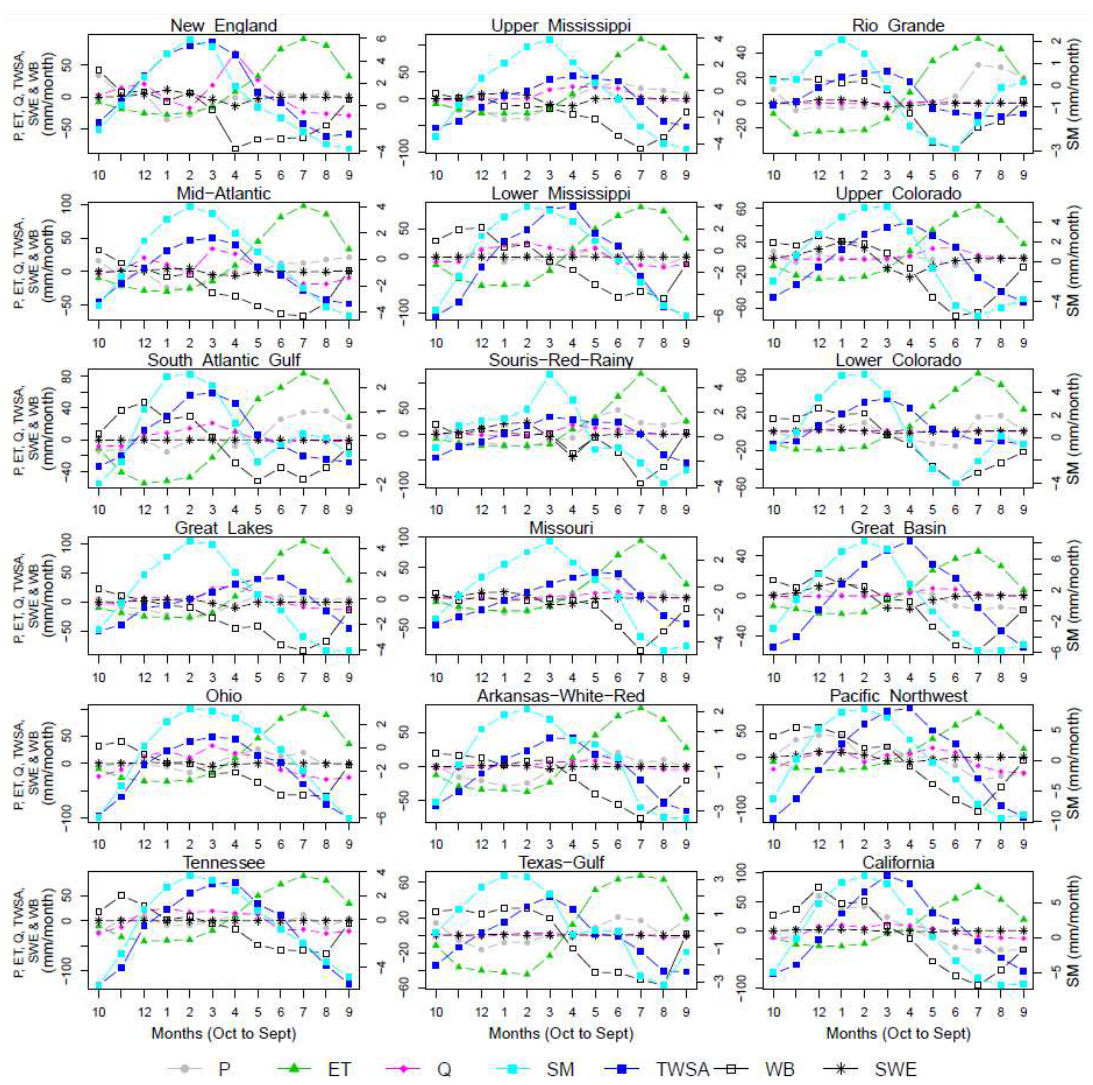
Figure 6. Comparison of hydrologic basin GRACE TWSA against other important hydrologic fluxes and parameters: (precipitation (P), evapotranspiration (ET), runo ff (Q), snow water equivalent (SWE), water balance, WB (P-ET-Q), and soil moisture (SM) (on secondary Y-axis)), all derived as a deviation from their respective decadal